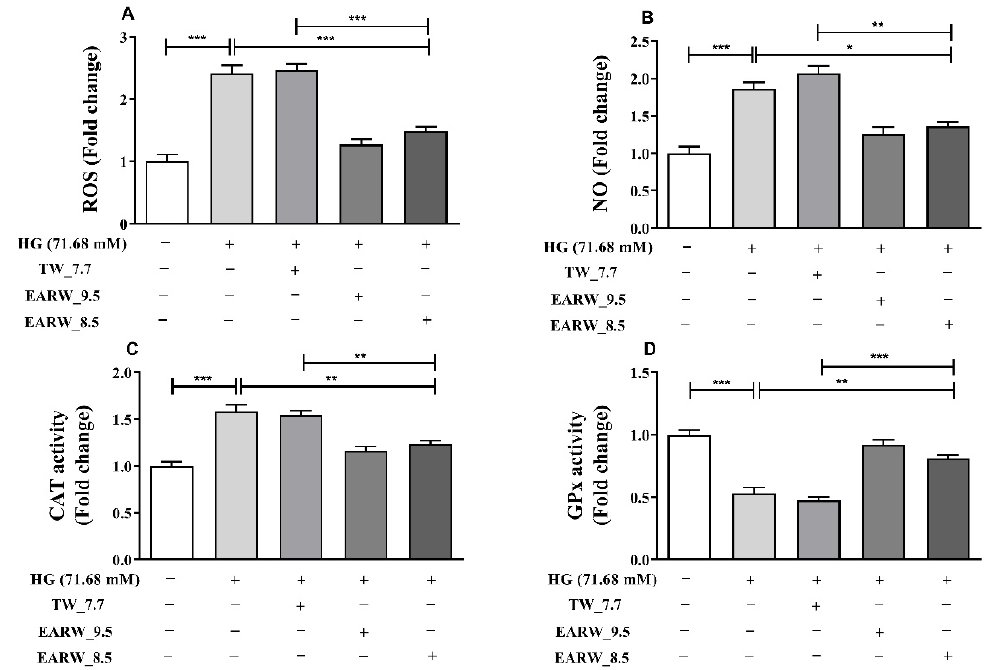
Figure 2. OS markers, including ROS, NO, CAT, and GPx, were investigated to understand the effect of EARW_8.5 after HG-induction. HK-2 cells were induced with HG (71.68 mM) and treated with different experimental waters. After 24 h, ( A ) ROS, ( B ) NO, ( C ) CAT, and ( D ) GPx were analyzed. Values were calculated in mean ± SEM. * p < 0.05, ** p < 0.01, and *** p < 0.001 indicate significant differences when tested with ANOVA.